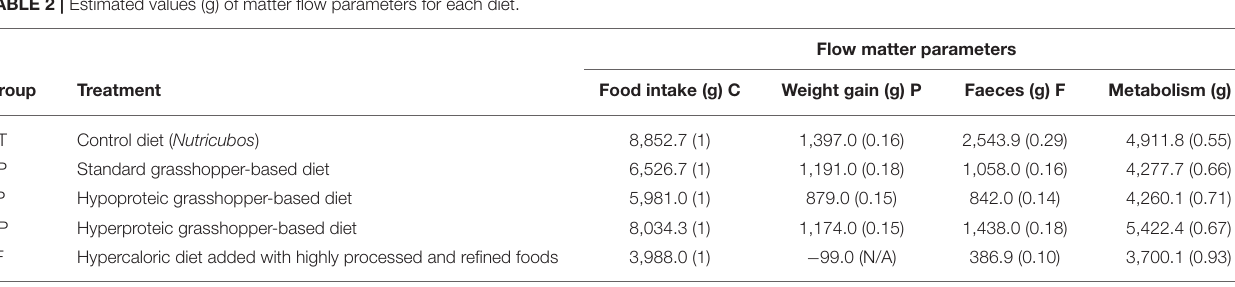
TABLE 2 | Estimated values (g) of matter flow parameters for each diet.